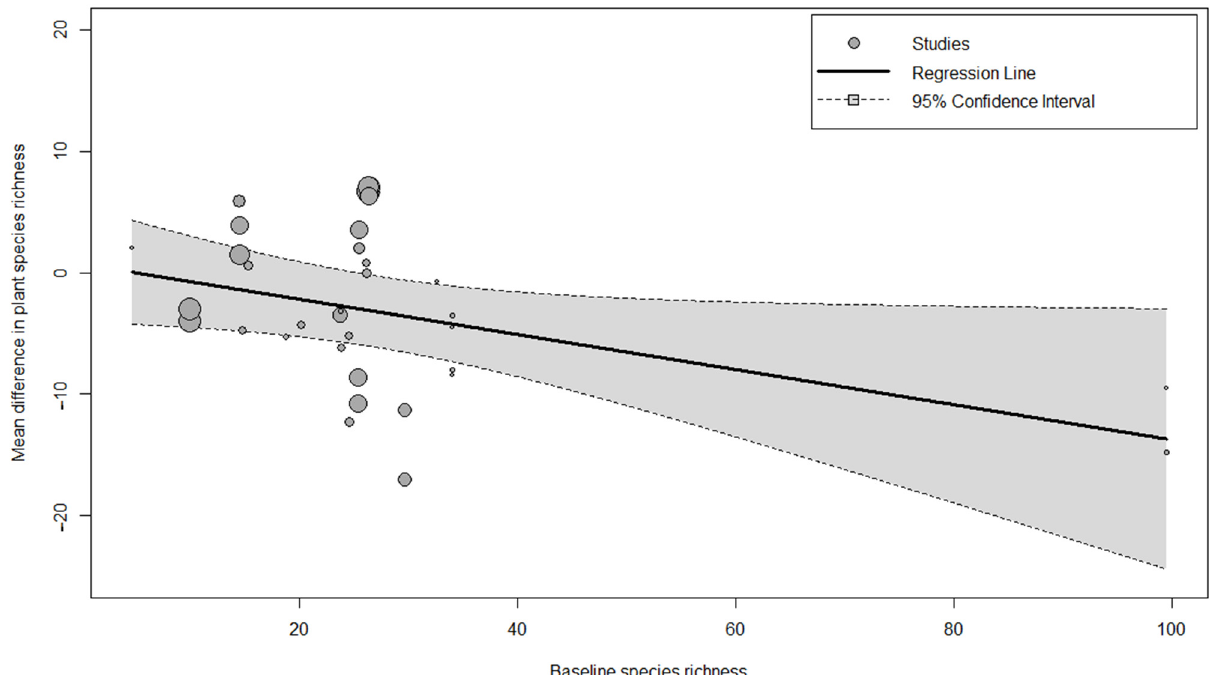
Figure 5. Mean difference in plant species richness with the addition of nitrogen in relation to baseline plant species richness in 14 studies included in the meta-analysis. Symbol size is a function of the weight in the model, with larger studies having a greater weight on model fit. Note: this result was dependent on the inclusion of the two effects from one study on the right-hand side of this plot which had particularly high baseline plant species richness, and there was no significant effect of baseline species richness when this study was removed from the final model.